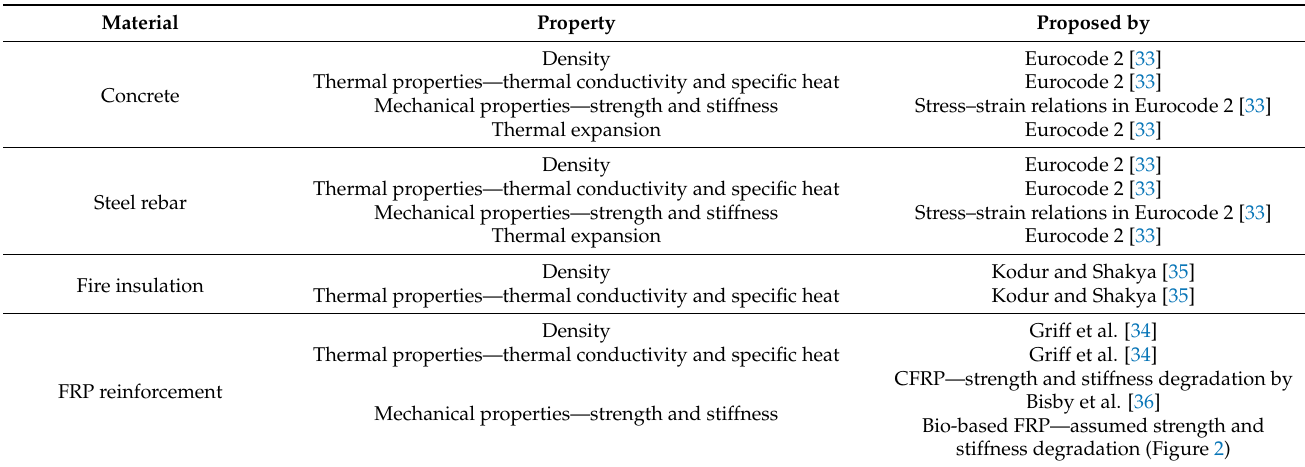
Table 1. Material properties used in the numerical model.